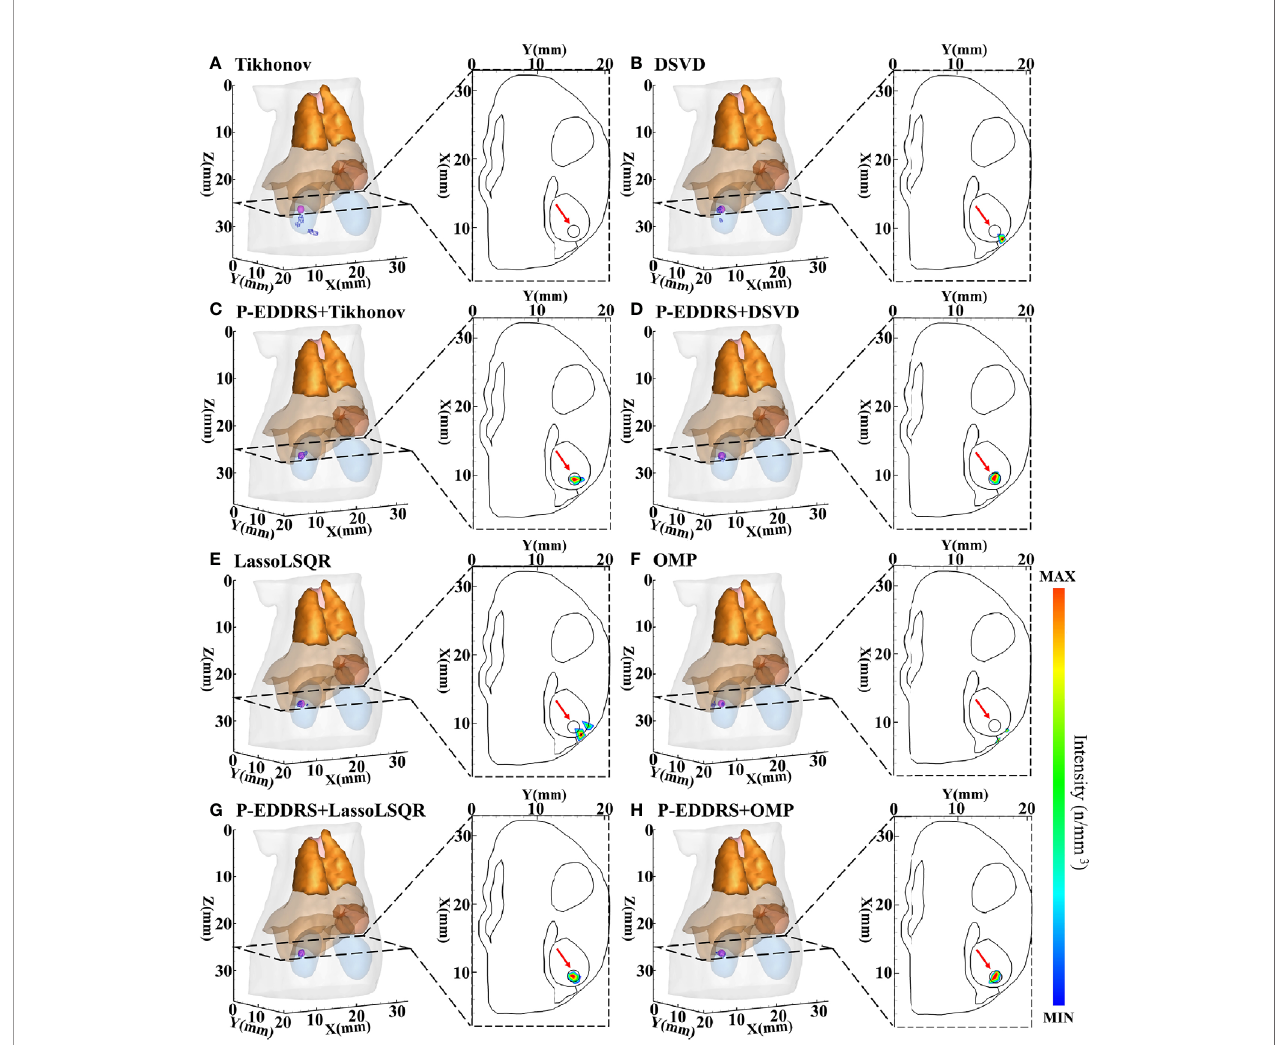
FIGURE 4 | Results of P-EDDRS framework feasibility veri fi cation in CLT. All results include 3D views and corresponding cross-section views at the plane of Z = 25 mm. (A, B, E, F) The initial reconstruction source distribution of Tikhonov, DSVD, LassoLSQR, and OMP algorithms, respectively. (C, D, G, H) The radiation source distribution obtained by the corresponding algorithms of panels (A, B, E, F) after using P-EDDRS framework. P-EDDRS, probabilistic energy distribution density region scaling; CLT, Cerenkov luminescence tomography; DSVD, damped singular value decomposition; LassoLSQR, Lasso and Least Square QR- factorization; OMP, orthogonal matching